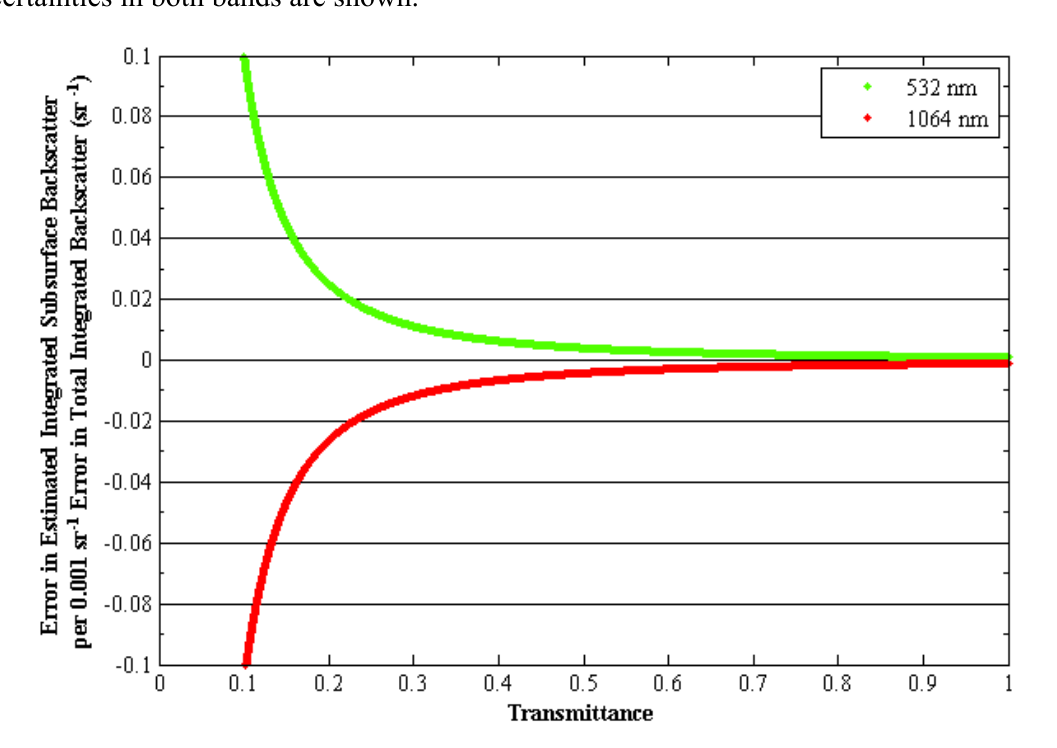
Figure 6. Error in the subaqueous integrated backscatter for a 0.001 sr − 1 error in the total integrated attenuated backscatter. This level of uncertainty was observed in the CALIOP data when comparing different numerical integration schemes. The errors associated with uncertainties in both bands are